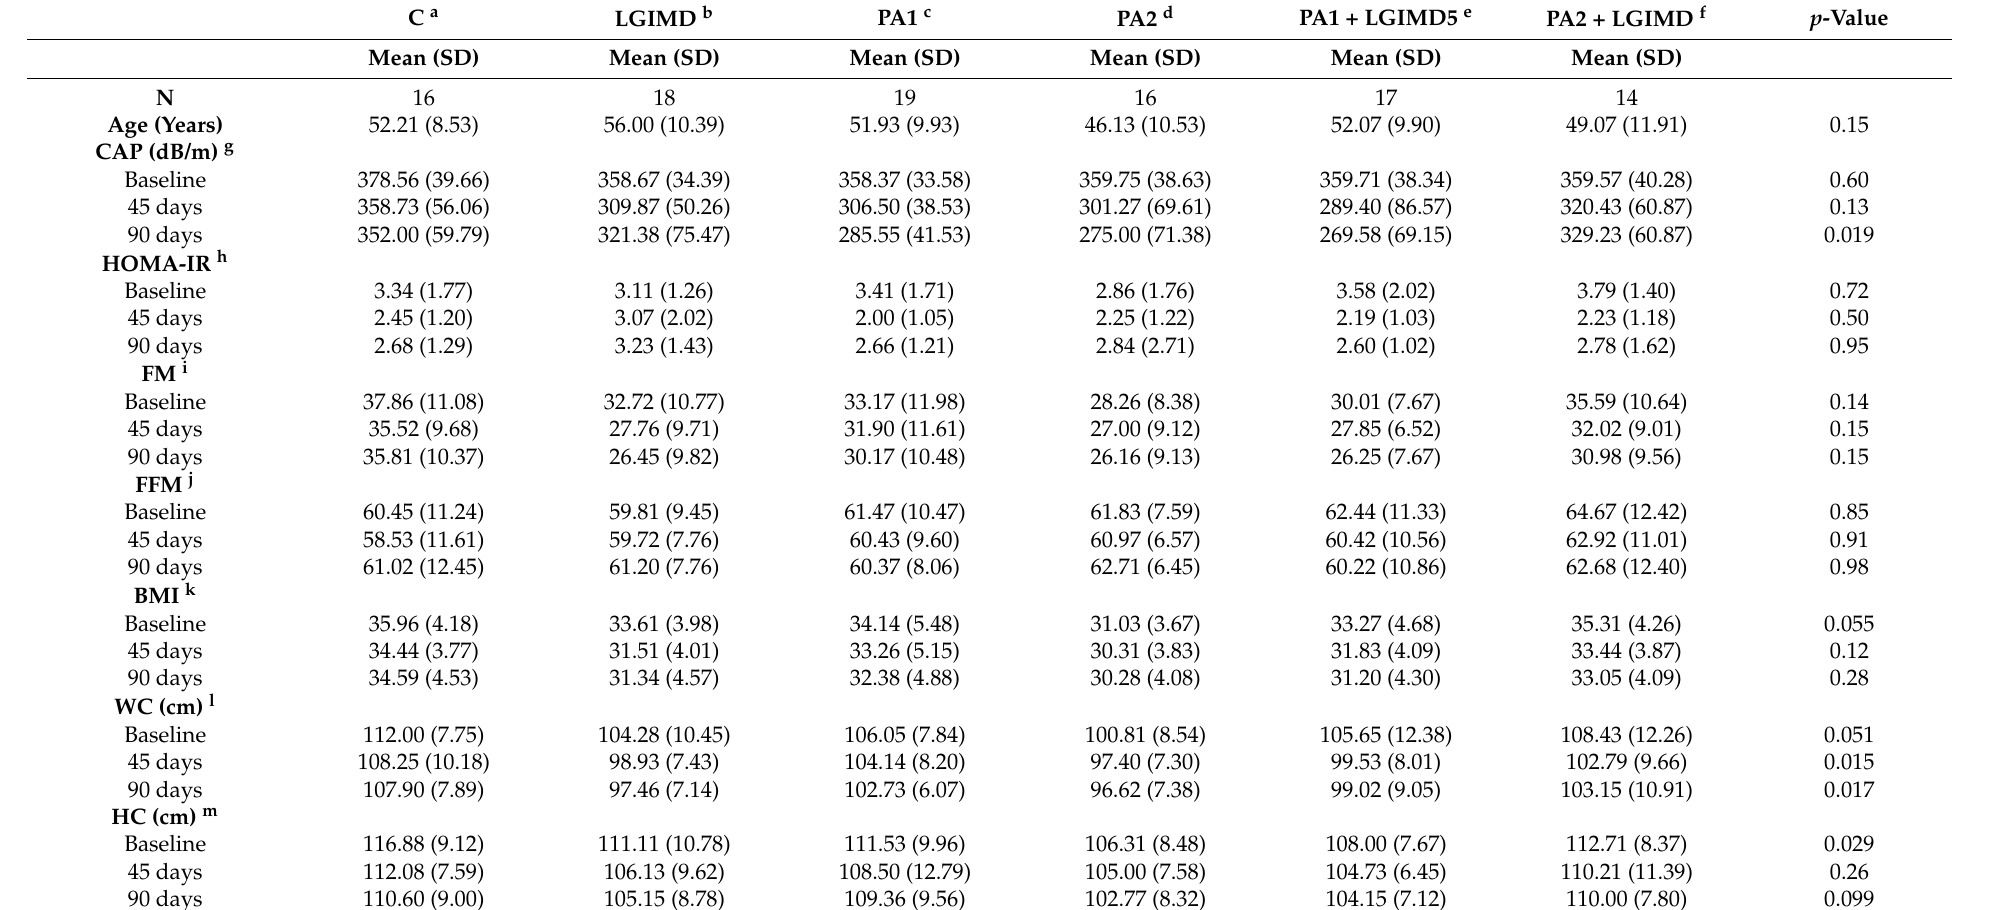
Table A3. Anthropometric and Biochemical Characteristics of Severe NAFLD Participants by Intervention Arms and Time. NutriAtt Trial, Castellana Grotte,